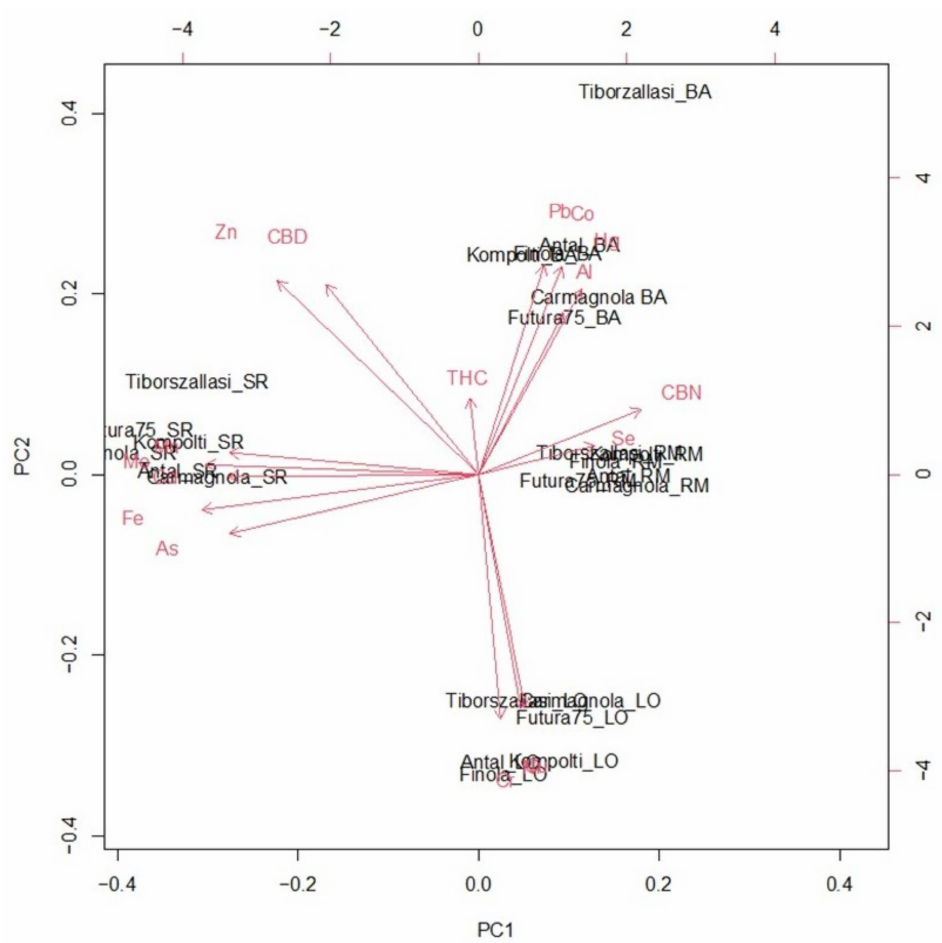
Figure 5. Two-dimensional principal component analysis (PCA) biplot of the first two principal components (PCs) obtained from the variables (i.e., inorganic elements and cannabinoids) investigated in the Italian hemp